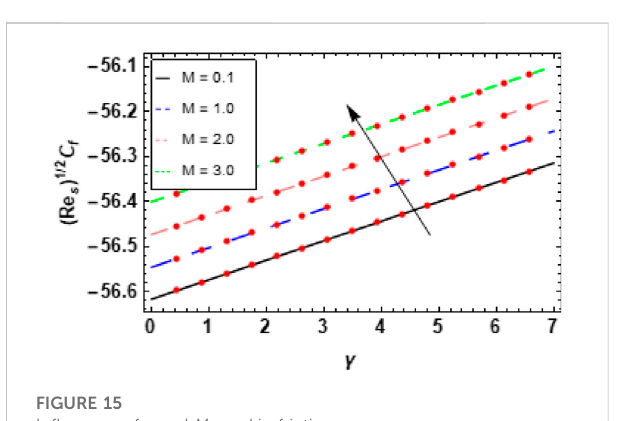
FIGURE 17 Effects of Q and β on Nu s ( Re s ) − 1/2